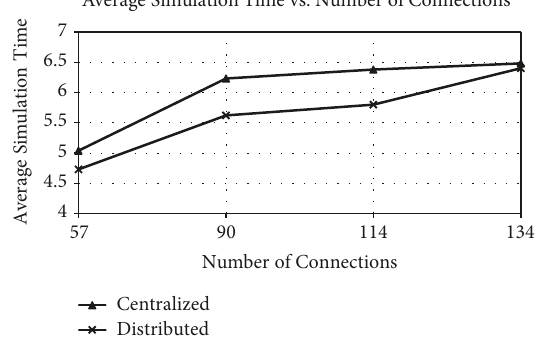
Figure 11: Average connection established time vs number connec- tions in Finland